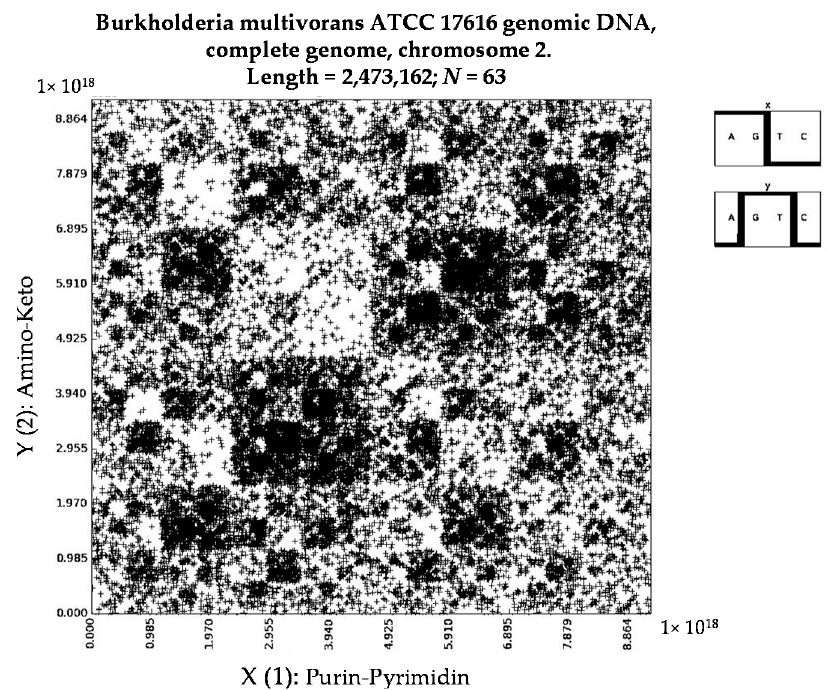
Figure 5. The pattern of the sequence “Burkholderia multivorans ATCC 17616 genomic DNA, complete genome, chromosome 2” with 2,473,162 nucleotides in the case of its division into 63-plets. Binary representations of N -mers are expressed in a form of n -bit binary numbers, the quantity of kinds of which is equal to 2 n . For example, the set of 3-bit binary numbers contains 2 3 = 8 members: 000, 001, 010, 011, 100, 101, 110, 111 (their equivalents in decimal notation are 0, 1, 2, 3, 4, 5, 6, 7). Decimal equivalent of the biggest n -bit binary member in a set of n -bit binary numbers is equal to 2 n − 1. Such sets of N -bit binary numbers are named “dyadic groups” (see details in [6]).